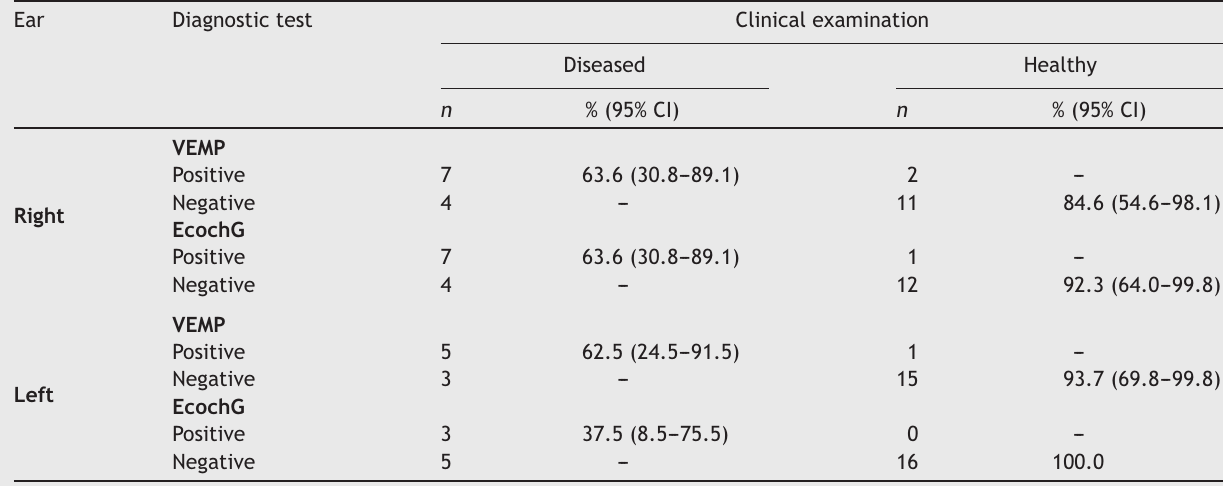
Sensitivity and specificity values, by type of test in both ears.